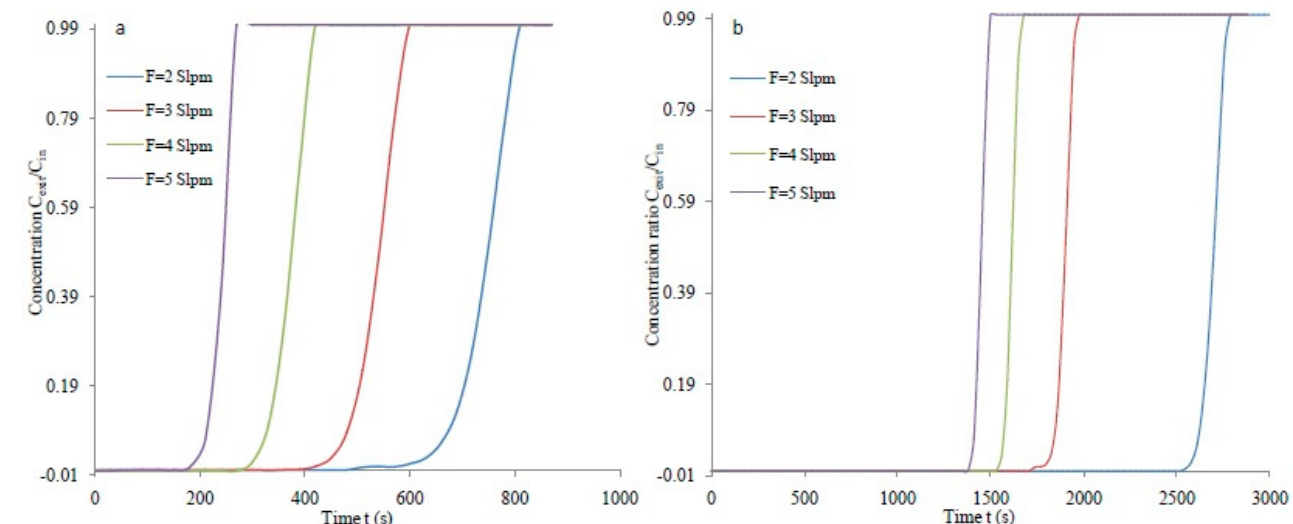
Figure 8. Flow rate dependence of adsorption profiles at C in = 5%, T = 298 K , ( a ) MS-3Å and ( b ) AC-SY.